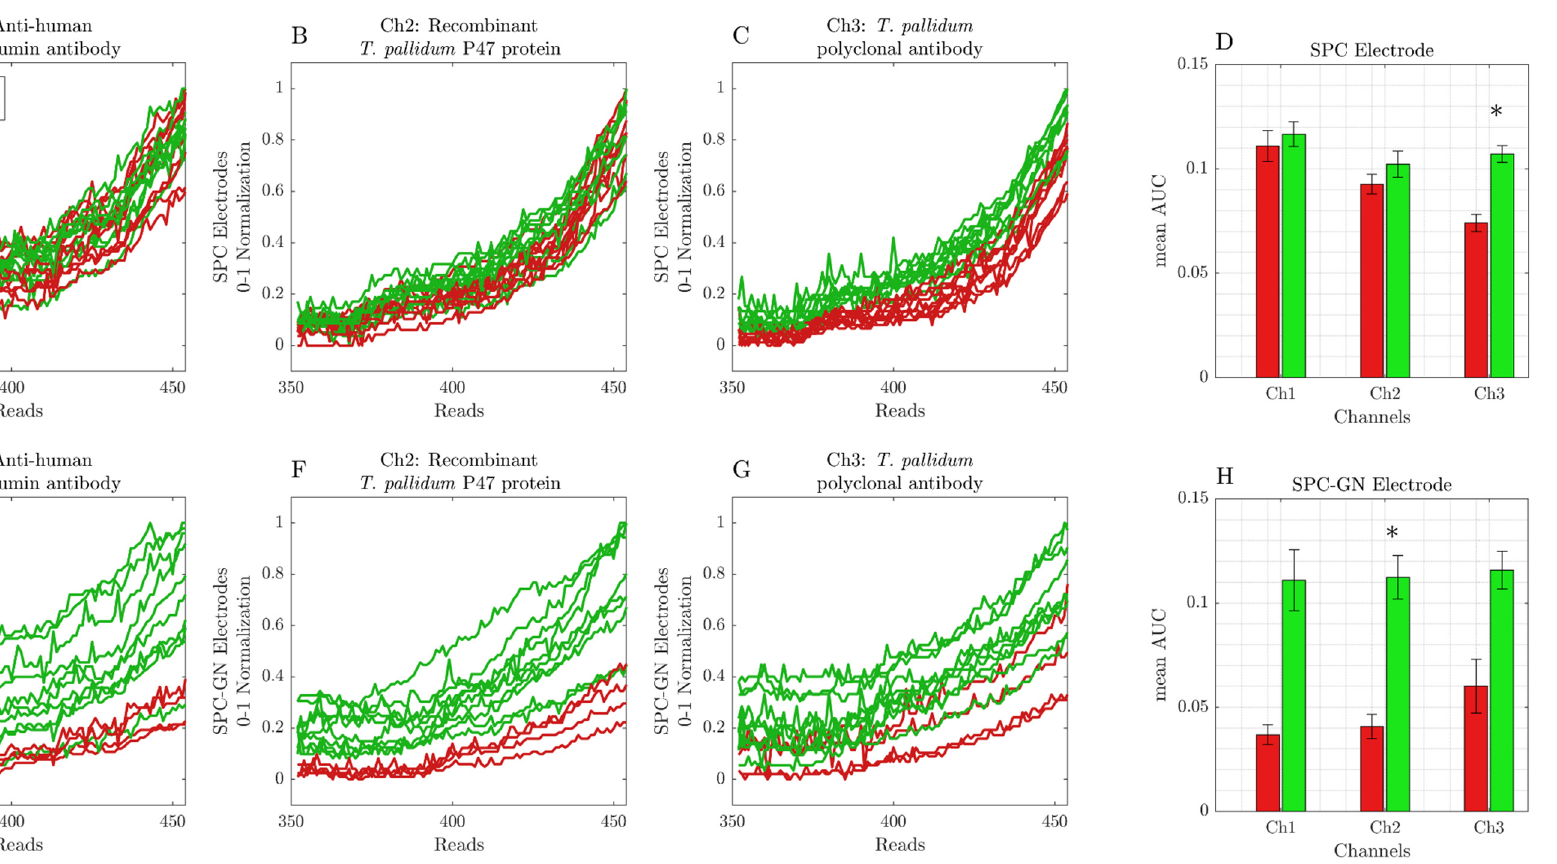
Figure 2. Cyclic voltammetry data were obtained from readings immediately (T0 ′ ) after incubating infected and uninfected samples in SPC or SPC-GN electrodes. Each sample was submitted for 454 readings for each channel, with an interval of 9.25 ms. ( A ) anti-human serum albumin (Ch1) in SPC electrodes; ( B ) recombinant T. pallidum p47 protein (Ch2) in SPC electrodes; ( C ) T. pallidum polyclonal antibody (Ch3) in SPC electrodes; ( D ) AUC data of infected and uninfected samples using SPC electrodes; ( E ) anti-human serum albumin (Ch1) in SPC-GN electrodes; ( F ) recombinant T. pallidum p47 protein (Ch2) in SPC-GN electrodes; ( G ) T. pallidum polyclonal antibody (Ch3) in SPC-GN electrodes; ( H ) AUC data of infected and uninfected samples using SPC-GN electrodes. The * indicates the differences that resulted statistically significant for the Mann–Whitney U test after Bonferroni correction (at significance level of α =0.05).